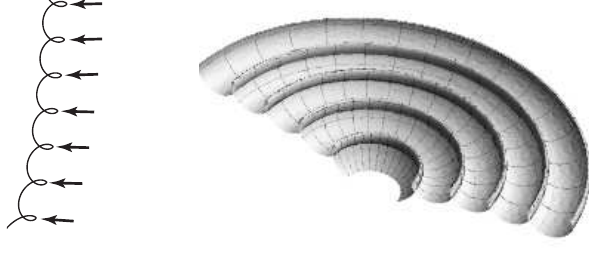
Figure 5 - Generating curve and the surface of revolution of Example